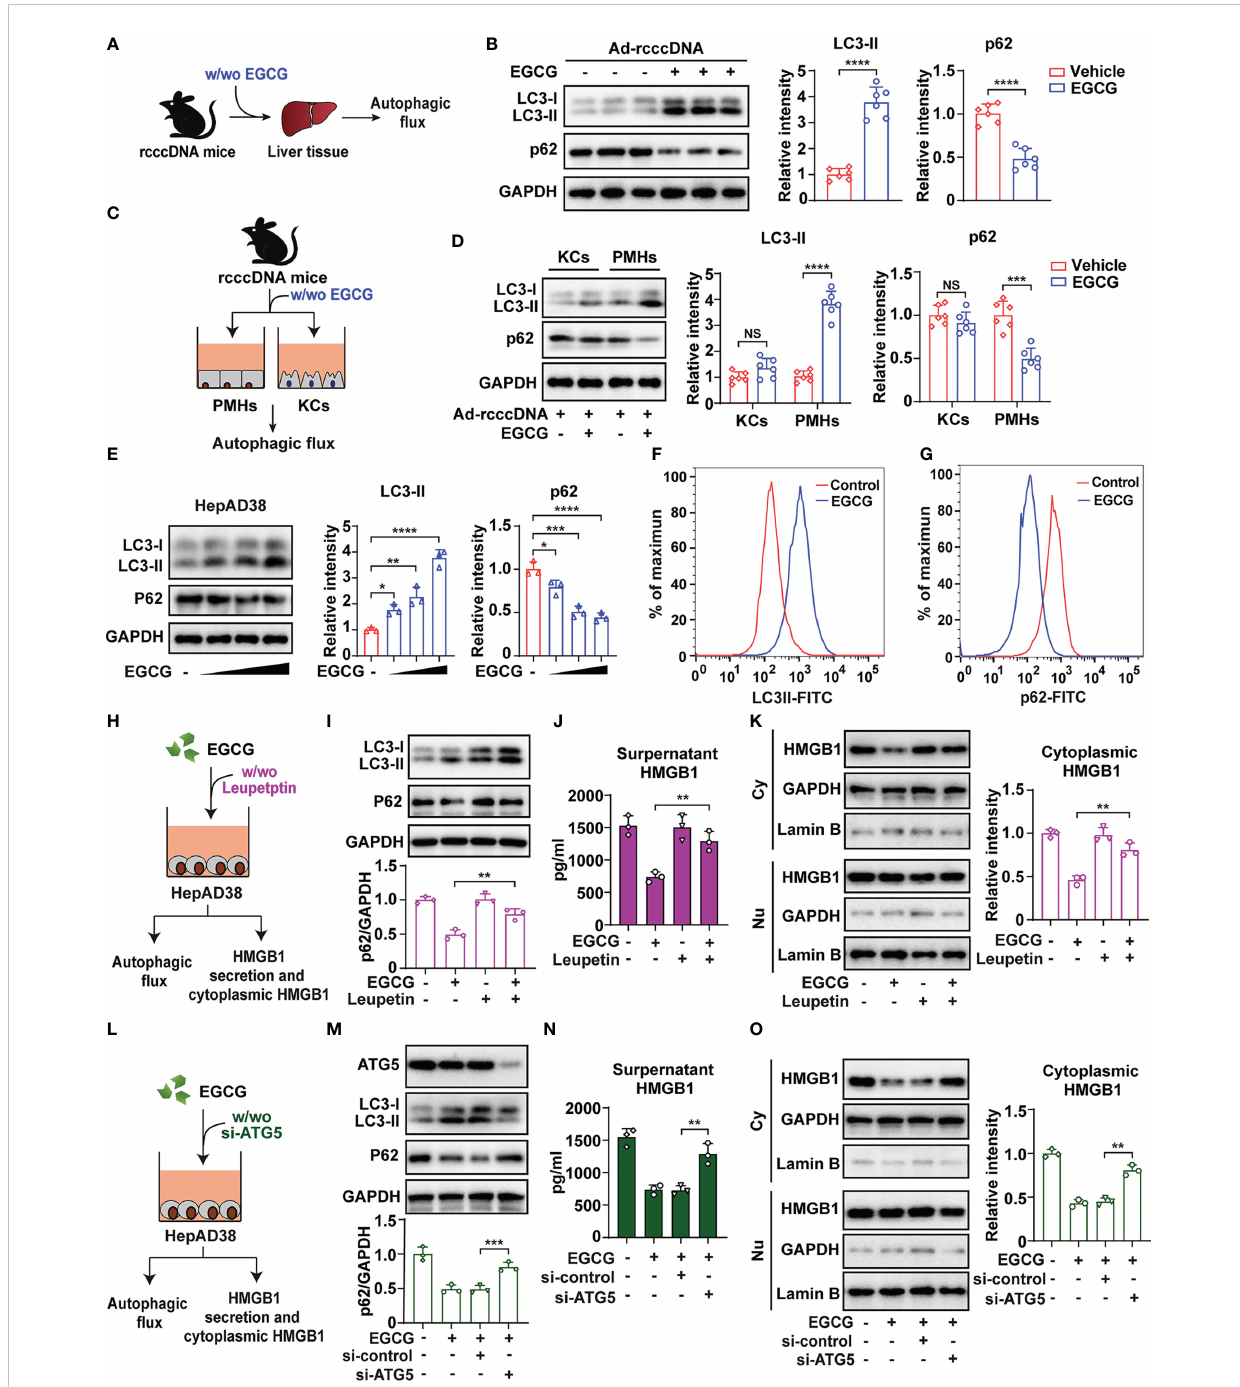
FIGURE 4 EGCG promotes the degradation of cytoplasmic HMGB1 through activating autophagic fl ux in hepatocytes. (A) Schematic experimental setup: rcccDNA mice were treated with or without 25 mg/kg EGCG daily for 42 days, followed by determination of autophagic fl ux in liver tissues (n = 6). (B) Protein levels of LC3-II and p62 were determined by Western blotting. Right panel: relative protein levels of LC3-II and p62 were determined by densitometric analysis, and the value from rcccDNA mice without EGCG treatment was set at 1.0. (C) Schematic experimental setup: PMHs and KCs were isolated from rcccDNA mice treated with or without EGCG for the determination of autophagic fl ux in cell lysates, respectively (n = 6). (D) The protein levels of LC3-II and p62 were determined by Western blotting as in (B, E) HepAD38/Tet off cells were treated with increasing doses of EGCG (12.5, 25 and 50 m M) for 24 h, followed by examining the protein levels of LC3-II and p62 by Western blotting as in (B, F, G) HepAD38/Tet off cells were treated with 25 m M of EGCG for 24 hours, followed by detecting the levels of LC3-II (F) and p62 (G) by FACS. (H) Schematic illustration of the effect of blocking autophagic fl ux by leupeptin on cytoplasmic HMGB1 and its following secretion from HBV replicating cells. (I, J) HepAD38 cells were treated with 25 m M EGCG for 24 h in the presence of 200 m g/mL of leupeptin, and the protein levels of LC3-II and p62 were determined by Western blotting as in B (I) . Supernatants HMGB1 levels (J) and HMGB1 protein levels in cytoplasmic and nucleic extracts of HepAD38 cells (K) were determined by ELISA and Western blotting, respectively. (L – O) Schematic illustration of the effect of blocking autophagic fl ux by si-ATG5 on cytoplasmic HMGB1 and its following secretion from HBV replicating cells (L) . HepAD38 cells were fi rst transfected with si-ATG5 for 48 h, followed by 25 m M EGCG treatment for another 24 h. Protein levels of LC3-II and p62 (M) , supernatant HMGB1 (N) and HMGB1 protein levels in cytoplasmic and nucleic extracts (O) were determined as in I to (K) All data are shown as mean ± SEM and compared by unpaired Student ’ s t test or one-way analysis of variance (ANOVA). * P < 0.05, ** P < 0.01, *** P < 0.001, **** P < 0.0001. NS, no signi fi